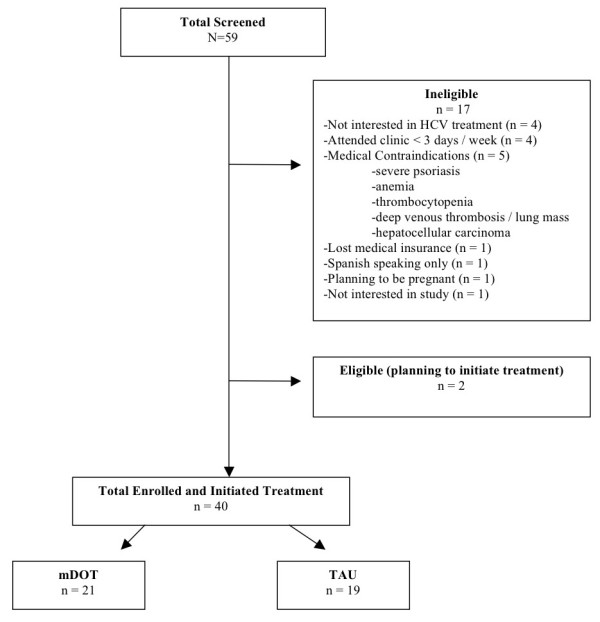
Flow chart of study recruitment and enrollment.